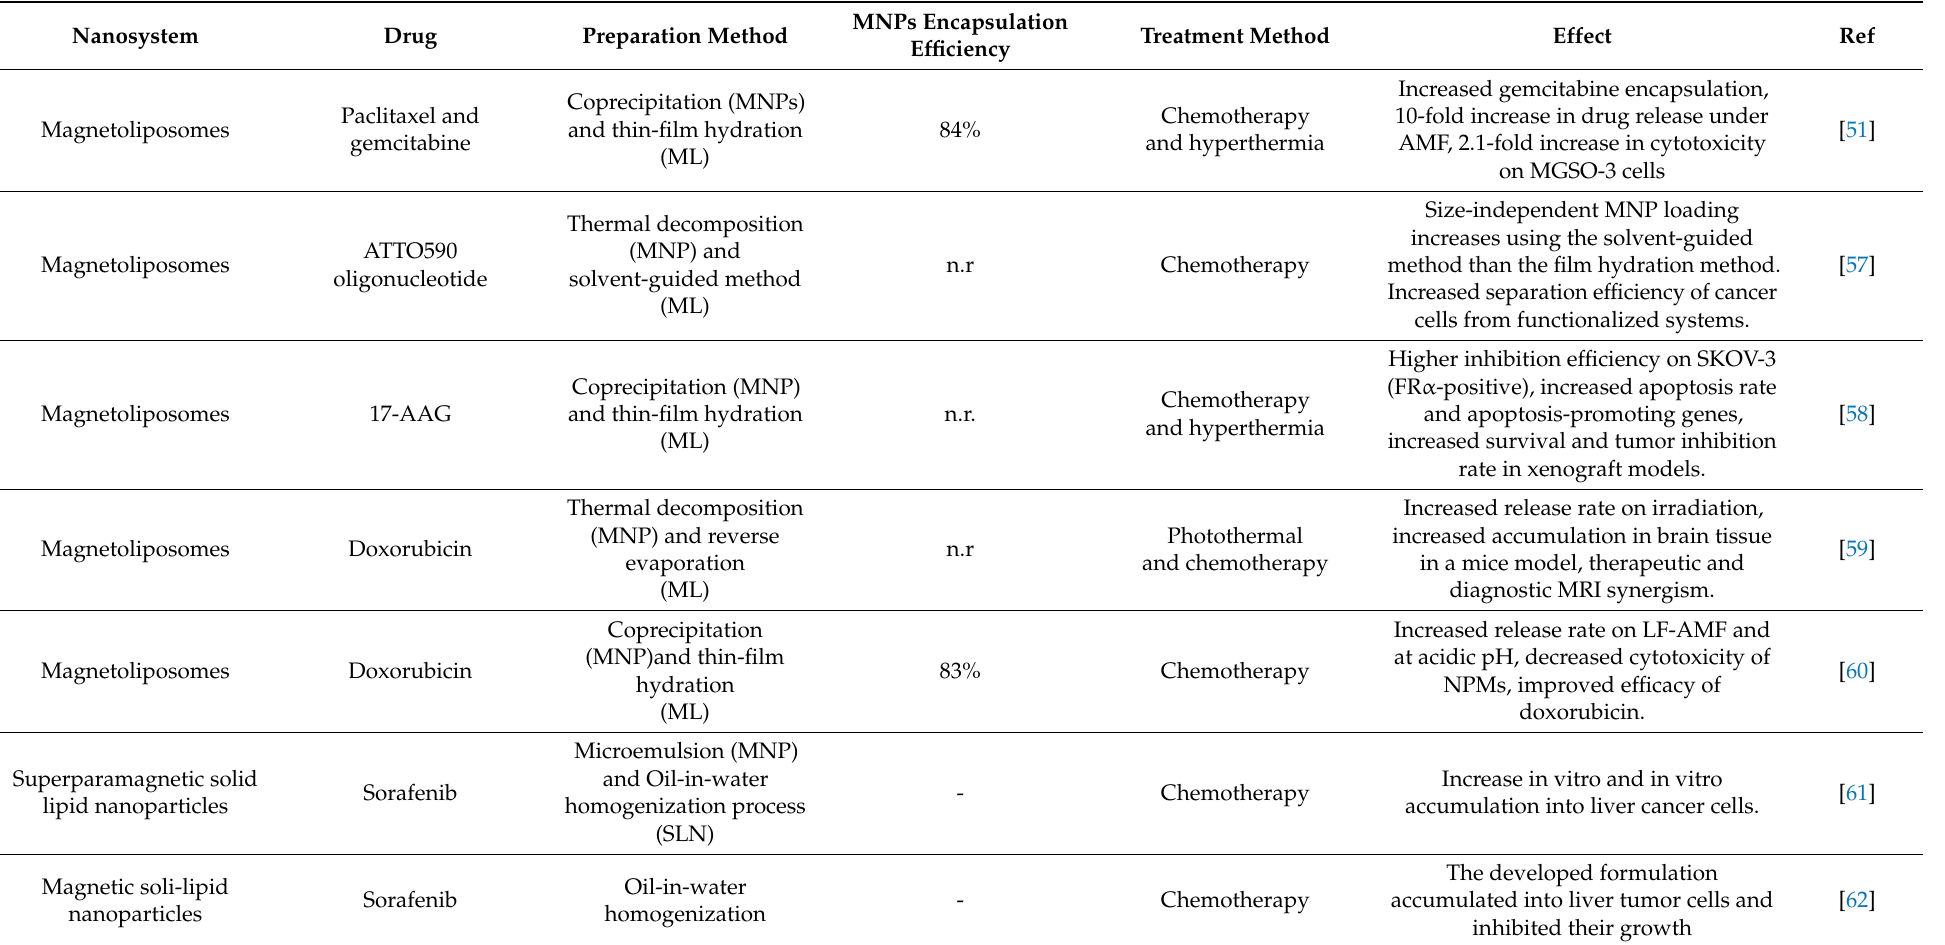
Table 1. Recent studies that investigated the antitumoral effect of hybrid magnetic lipid-based